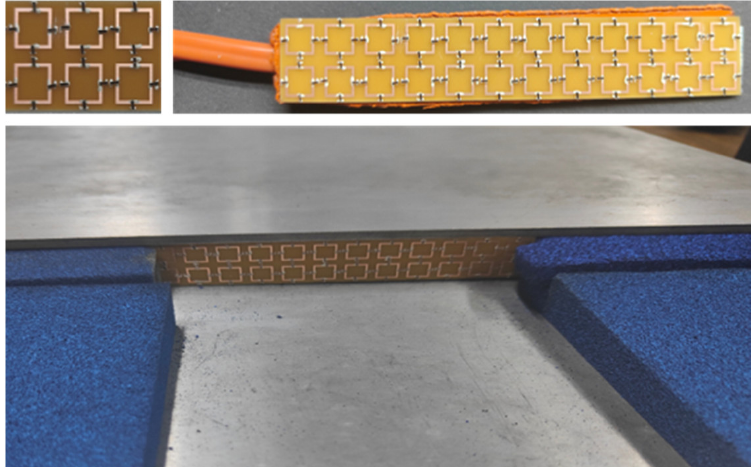
Figure 9. The TSAM unit, sample with the heating plate, and test device.